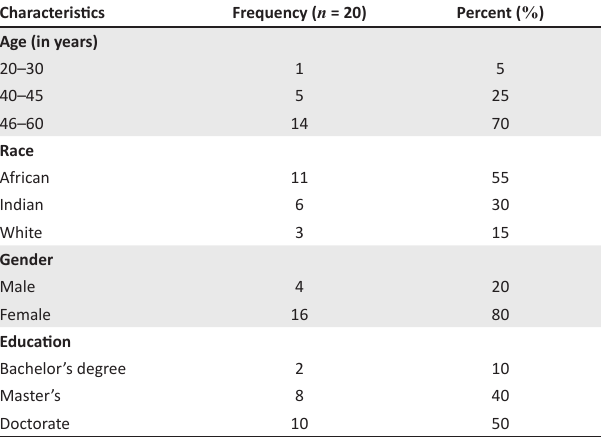
TABLE 1: Socio-demographic characteristics and profile of the participants. Characteristics